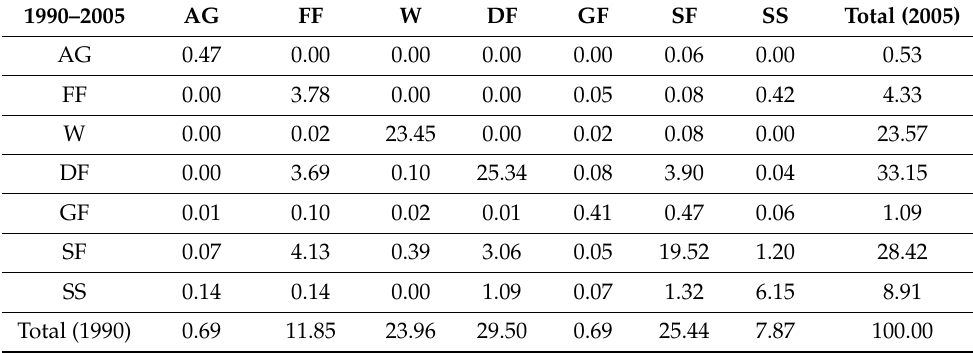
Table 3. Transition matrix of land occupation units (%) between 1990 and 2005.